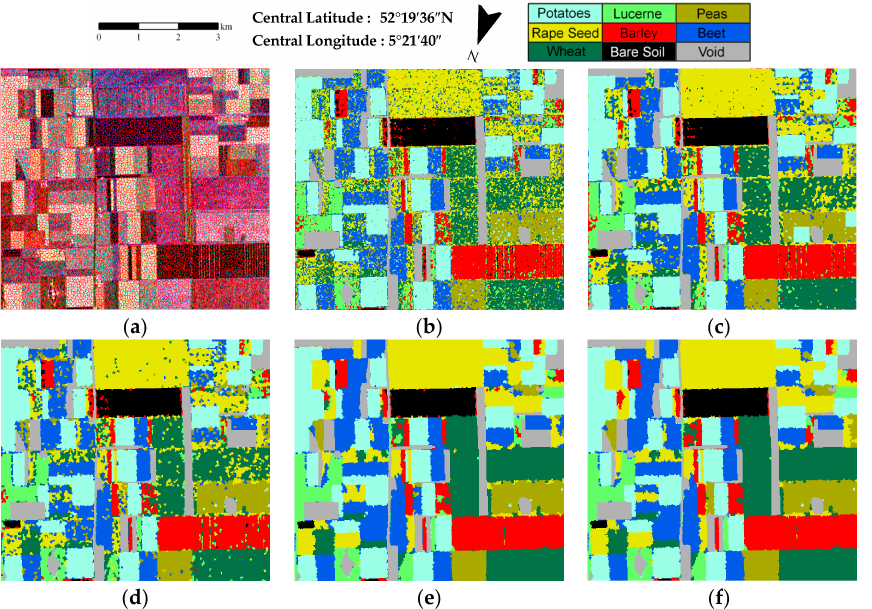
Figure 9. Classification results of the RADARSAT-2 image with different methods: ( a ) superpixel map; ( b ) KSEM; ( c ) KSEM-PLR; ( d ) SP-KSEM; ( e ) SP-WSEM-PLR (Wishart distribution SEM (WSEM)); and ( f ) SP-KSEM-PLR.